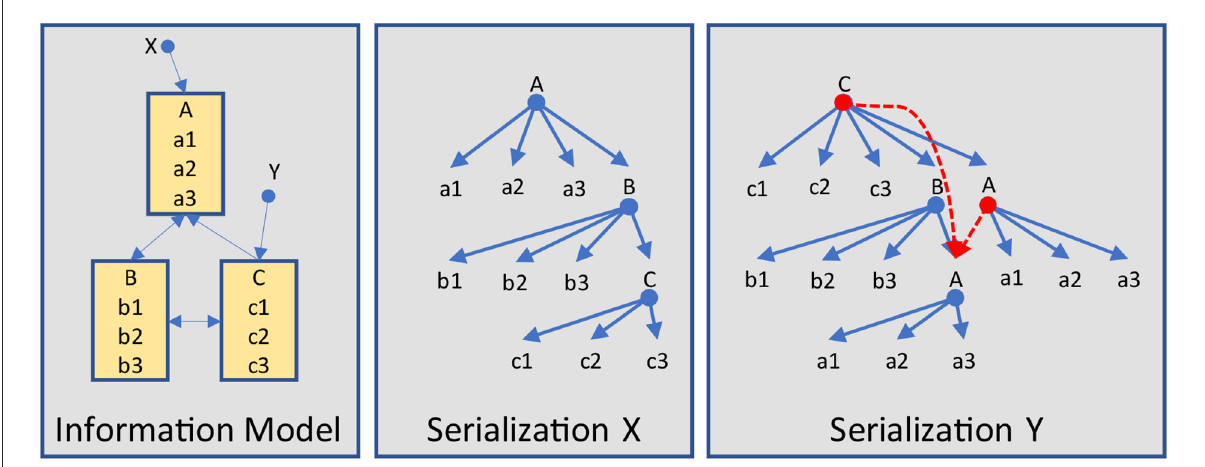
FIGURE11 Serialization examples.